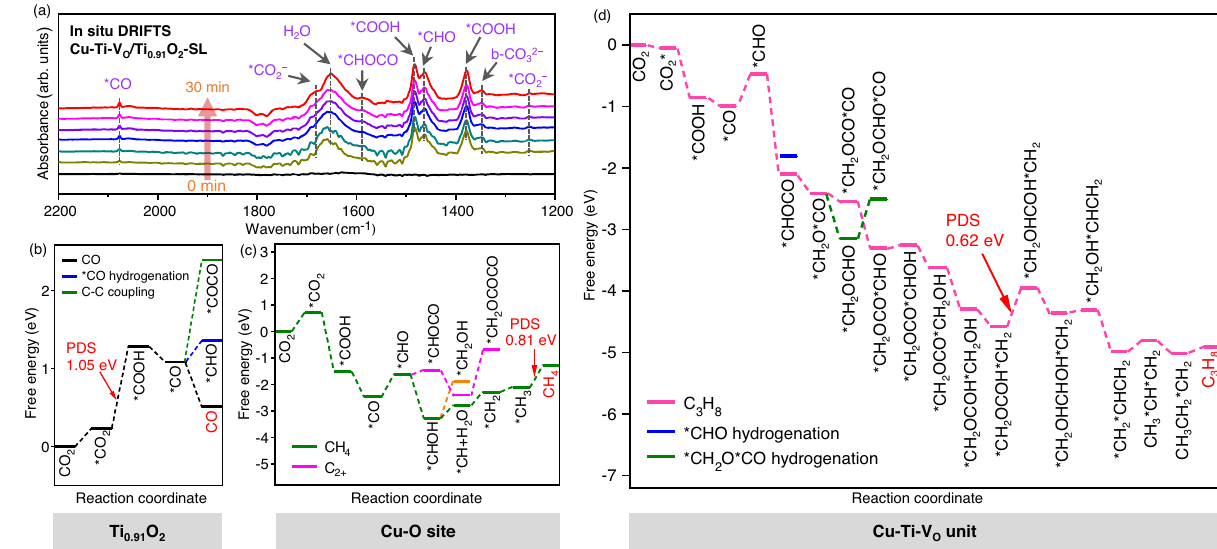
Fig. 4 | Mechanism studies of CO 2 reduction on Cu-Ti-V O /Ti 0.91 O 2 -SL. a In situ DRIFTS spectra of the photocatalytic CO 2 reduction on Cu-Ti-V O /Ti 0.91 O 2 -SL. Gibbs free energy diagrams of